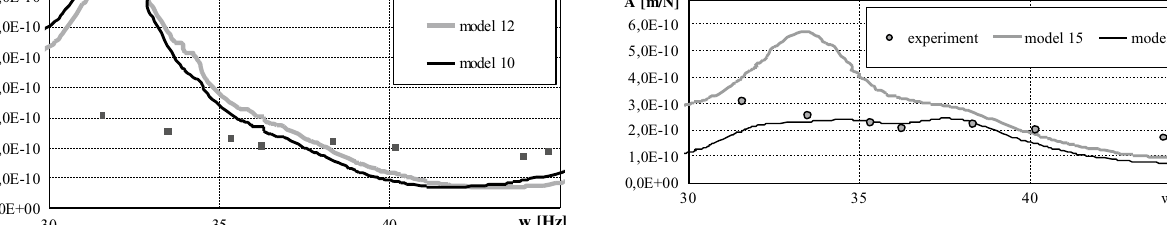
Fig. 14 Dependence of the displacement amplitudes of the forced oscillations of the support No. 4 on the frequencies for models 10 (basic) and 12 (taking into account the rigidity of the soil)